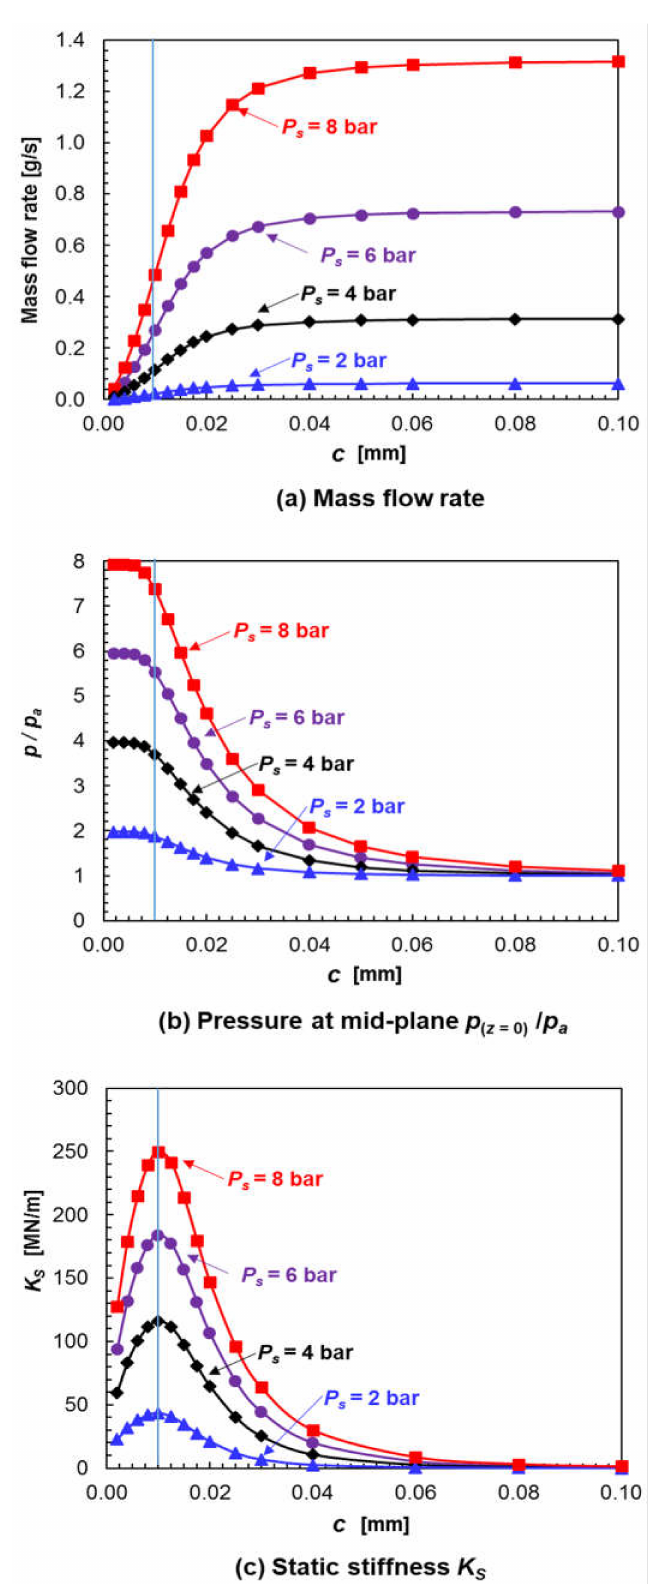
Figure 5. PGB static pressure at mid-plane, mass flow rate, and aerostatic stiffness vs. clearance ( c ). Air supply pressure p s = 2, 4, 6, and 8 bar; ( a ) Mass flow rate; ( b ) Pressure at mid-plane p ( z = 0) / p a ; ( c ) Static stiffness K S . Aerostatic operation ( Ω = 0) and null eccentricity ( e = 0) . Vertical lines denote clearance c = 0.01 mm for largest